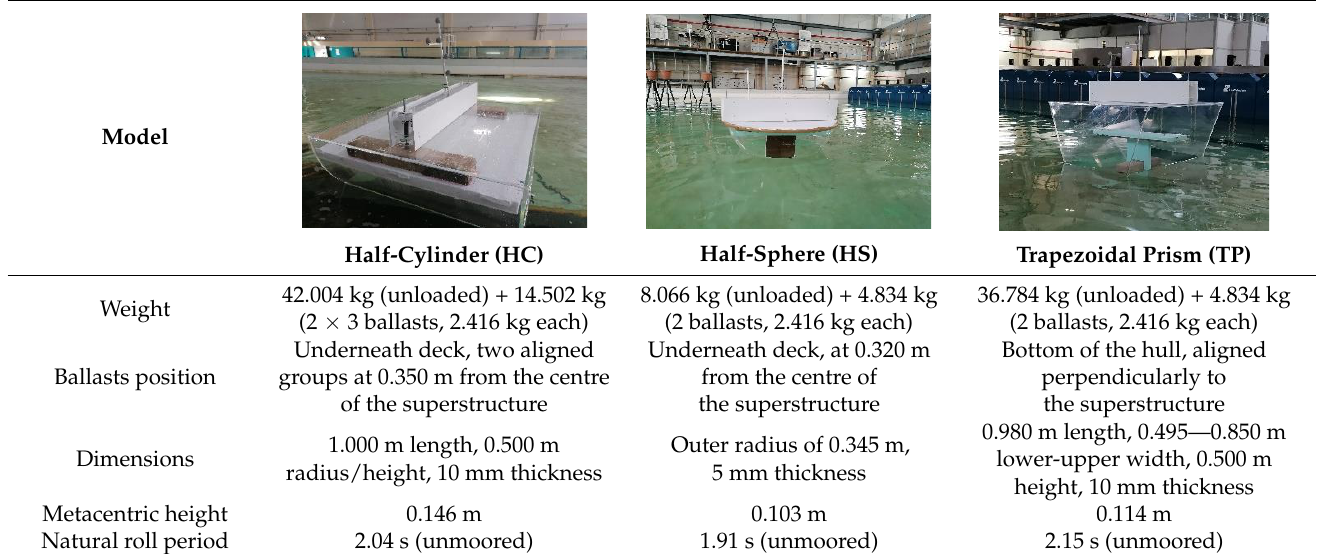
Table 1. Physical models: shape, dimensions and physical